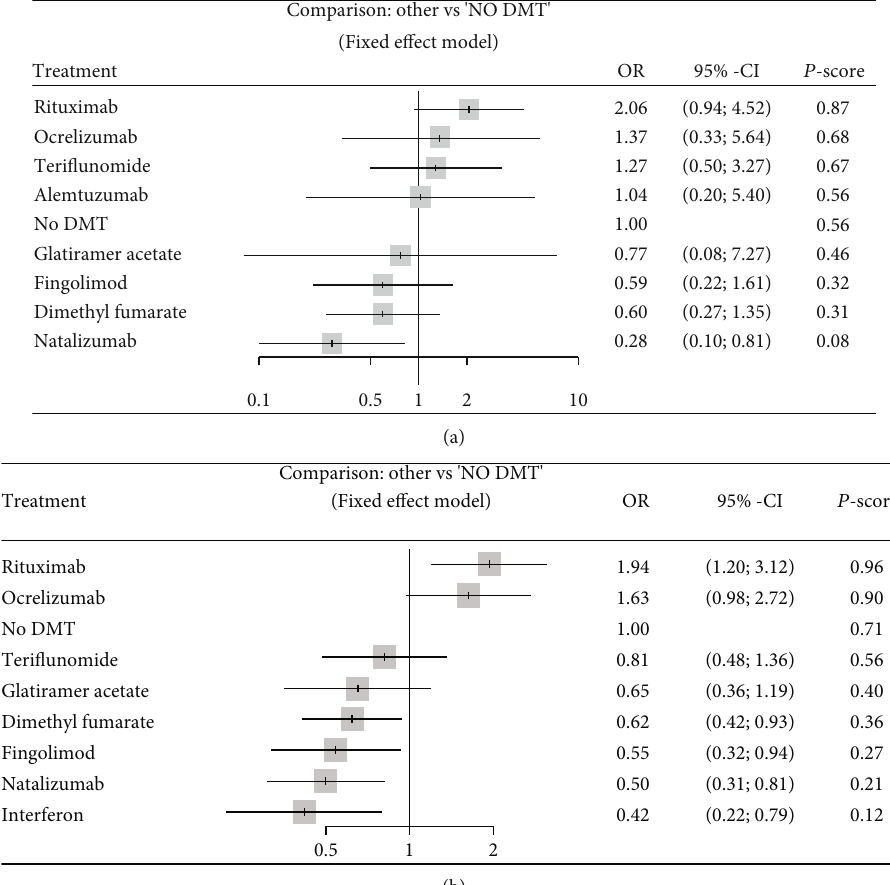
Figure 4: Forest plots of comparisons between DMTs and no DMTs for severity of COVID-19. (a) Results of univariate analyses. (b) Results of multivariate analyses. P score ranges from zero to 1. A higher P -score indicates a greater risk of developing severe COVID-19